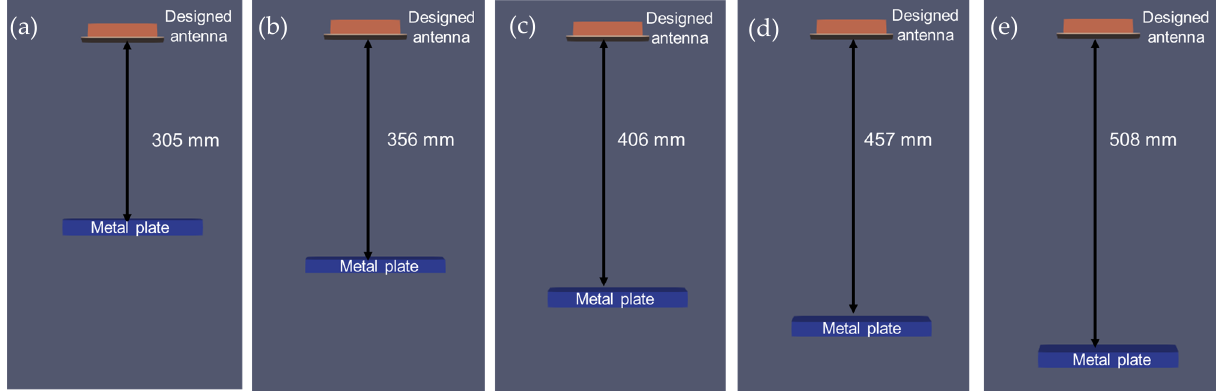
Figure 8. Simulation of the designed antenna at various depths: ( a ) 305 mm (12 inches), ( b ) 356 mm (14 inches), ( c ) 406 mm (16 inches), ( d ) 457 mm (18 inches), and ( e ) 508 mm (20